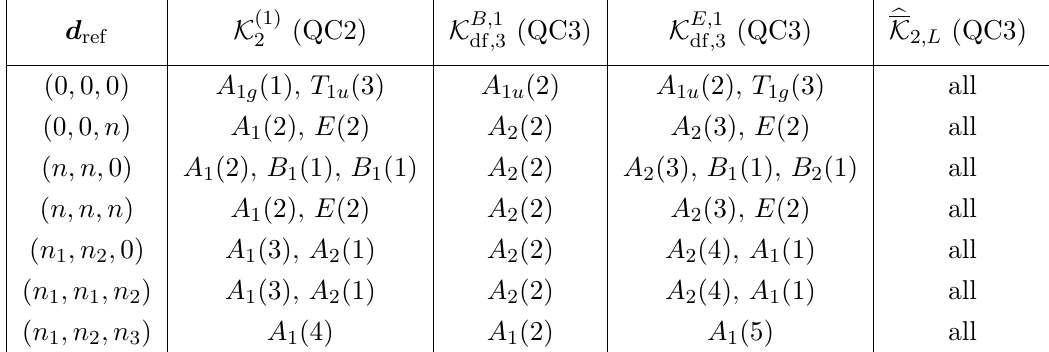
all Table 2. Irrep decompositions of the eigenvalues of two- and three-particles K matrices for differ- ent frames, and for both two- and three-particle quantization conditions (denoted QC2 and QC3, respectively). Frames are denoted as in table 1. Results assume both s - and p -wave dimers in the flavor-1 spectator channel and only s waves in the flavor-2 channel, and are for the L → ∞ limit. For finite L and energies in the range of validity of the quantization condition, some of the eigenvalues may be absent; see appendix A.3 for further discussion. The notation I ( n ) denotes that there are n nonzero eigenvalues in irrep I , a number that includes the multiplicity of the irrep. In assigning irreps, all particles are assumed to be pseudoscalars, so that, for example, the trivial irreps of two- and three-particle systems are the parity complements of each other. The description “all” in the final column indicates that there are nonzero eigenvalues in every irrep that is present for a given choice of E , particle masses, and L . Which irreps are present can be determined from the tables in appendix A.3. We observe that, aside from the final column, the total number